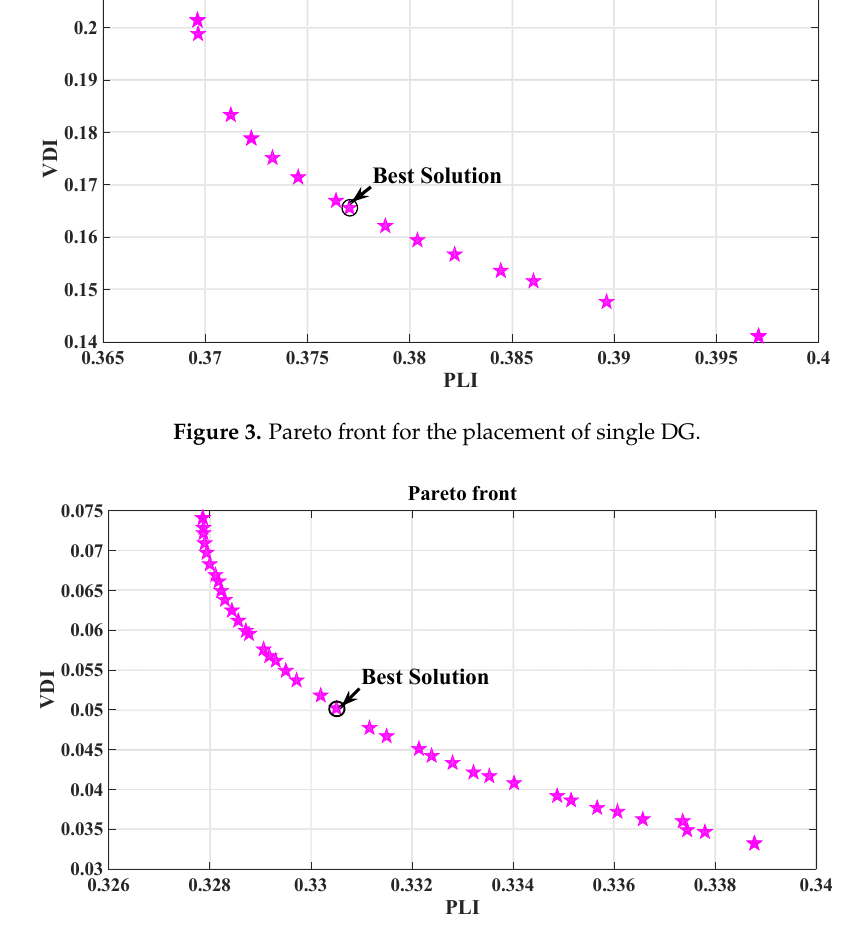
Figure 4. Pareto front for the placement of multiple DG.